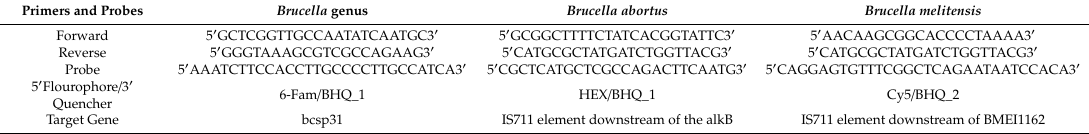
Table 1. Primers and probes for the Brucella genus and the species-specific quantitative real-time polymerase chain reaction (qRT-PCR).